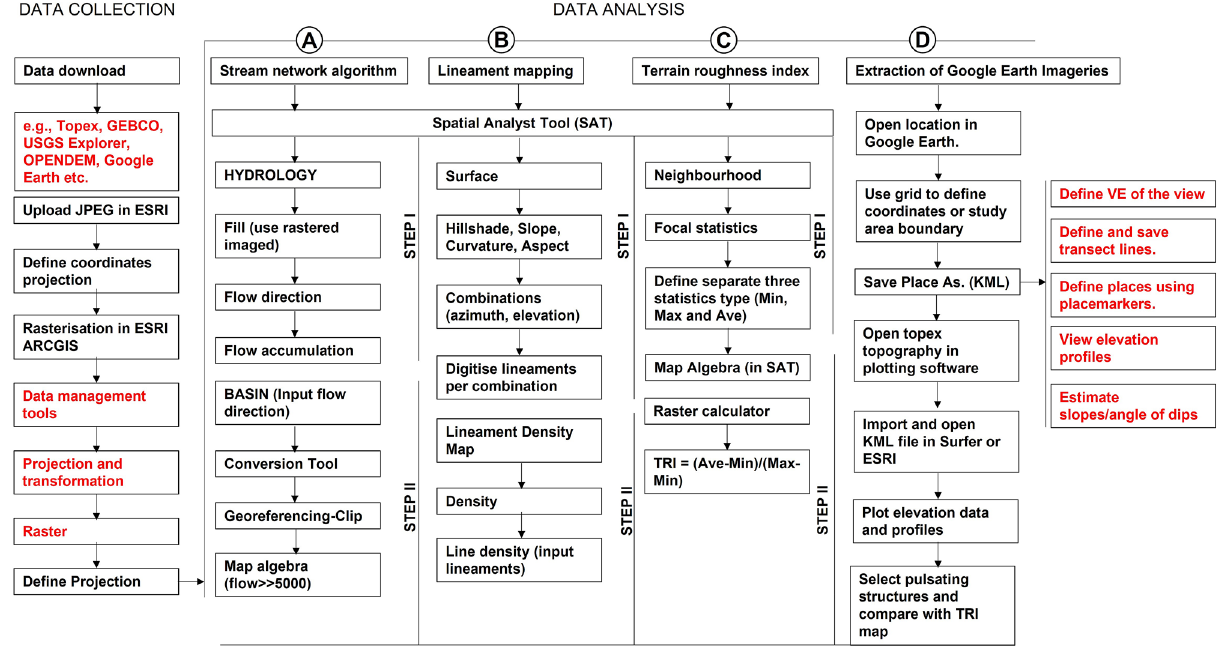
Figure 3. Workflow and algorithms used in this study. The workflow is divided into two main parts; Data collection and Data analysis, including ( a ) stream network delineation ( b ) lineament mapping ( c ) terrain roughness index calculation, and ( d ) extraction of google earth images. N.B: sub-processes are shown in red